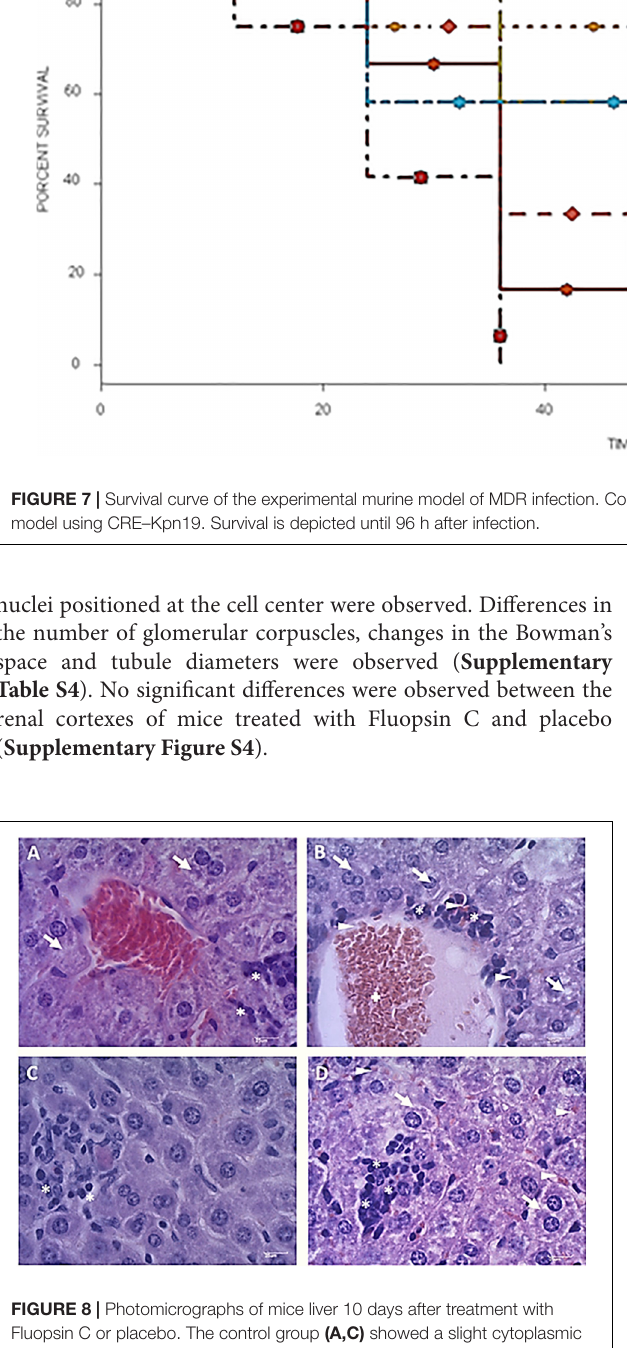
FIGURE 8 | Photomicrographs of mice liver 10 days after treatment with Fluopsin C or placebo. The control group (A,C) showed a slight cytoplasmic vacuolation of hepatocytes (arrow) and discrete inflammatory infiltrate (asterisk), while animals treated with Fluopsin C (B,D ) presented moderate vessel congestion (cross), marked vacuolation of the cytoplasm (arrow), moderate inflammatory infiltrate (asterisk) and bleeding (arrowhead). Similar images were observed in other fields, in every time point. Color: HE. Scale bar: 25 µ